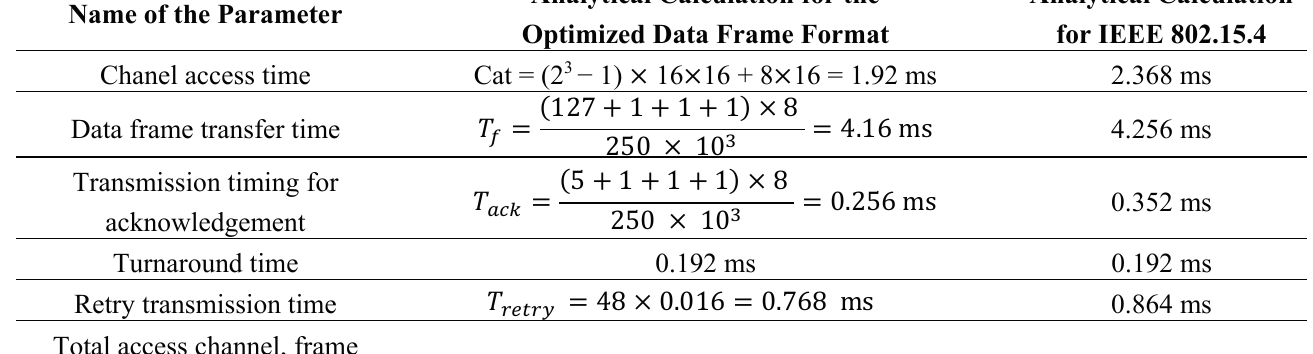
Table 1. Comparison of BN-MAC and IEEE 802.15.4 based on the data frame model. Name of the